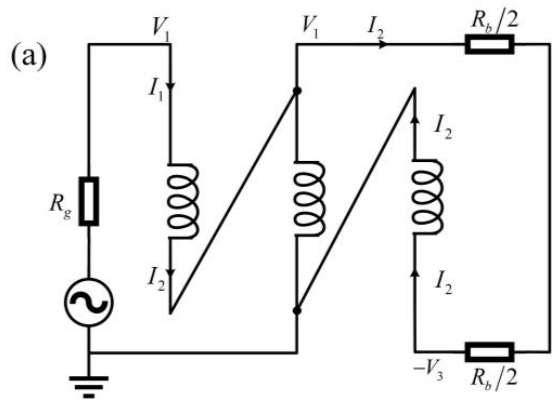
Figure 10. The prototype of the improved feeding network. ( a ) the circuit principal diagram of balun and ( b ) photo of feeding network. Table 3. Statics table of meteor quantity. Time (UT Hour) Metero Radar with ATRAD